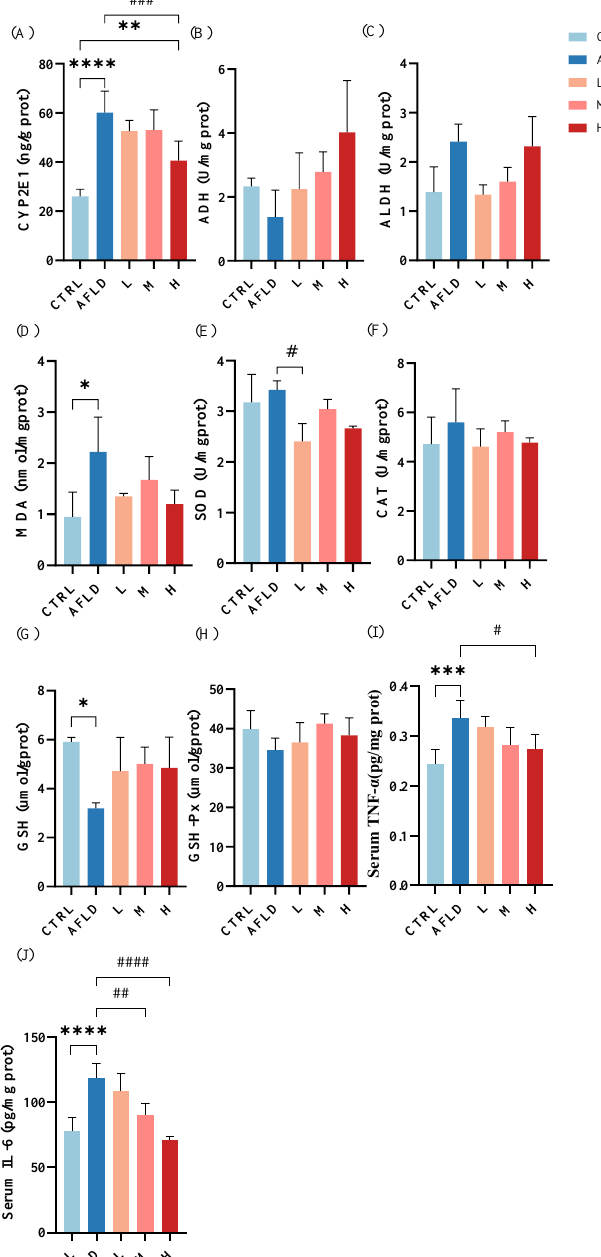
Figure 3. The effects of DOFE on alcohol metabolism in mice exposed to chronic alcohol consump- tion. ( A ) CYP2E1: cytochrome P450 2E1; ( B ) ADH: alcohol dehydrogenase; ( C ) ALDH: aldehyde dehydrogenase; ( D ) MDA: malondialdehyde; ( E ) SOD: superoxide dismutase; ( F ) CAT: catalase; ( G ) GSH: glutathione; ( H ) GSH-Px: glutathione peroxidase; ( I ) TNF-α: tumor necrosis factor-α; ( J ) IL-6: interleukin-6. CTRL, the control group; AFLD, the model group; DOFE, Dendrobium officinale flower extract; L, the low concentration of DOFE; M, the medium concentration of DOFE; H, the high concentration of DOFE. * p < 0.05, ** p < 0.01, *** p < 0.001, **** p < 0.0001 for the CTRL groups compared with the DOFE median supplementary groups and the DOFE high supplementary groups; # p < 0.05, ## p < 0.01, ### p < 0.001, #### p < 0.0001 for the AFLD group compared with the DOFE low supplementary groups, the DOFE median supplementary groups, and the DOFE high supplementary